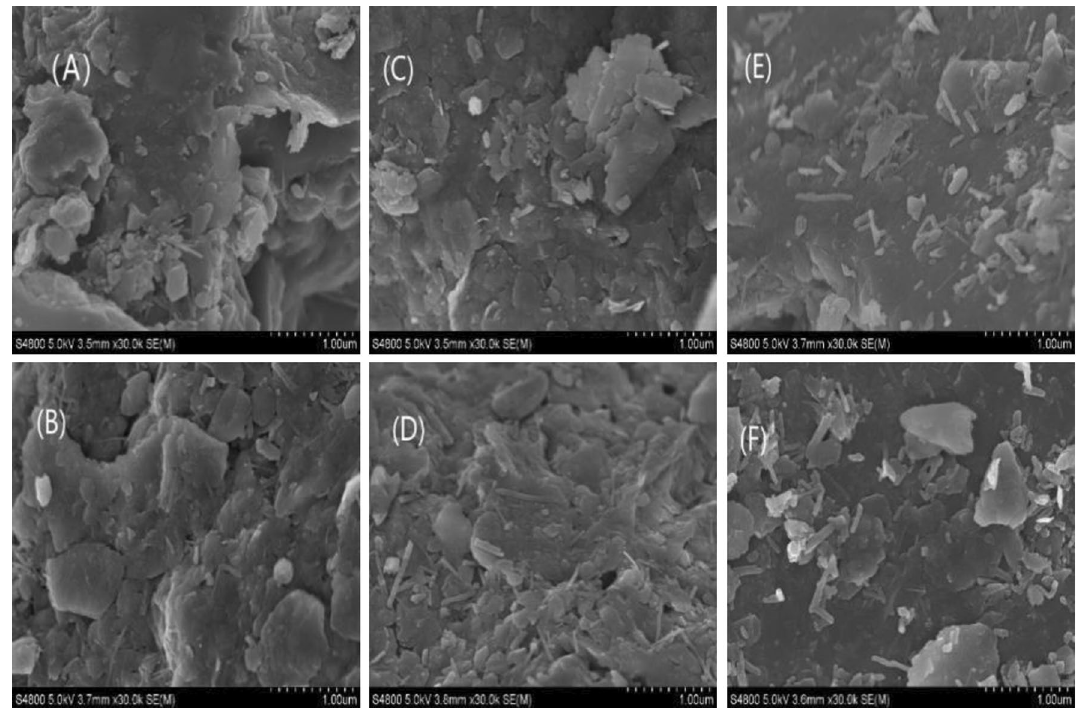
Figure 1. SEM micrographs of the three soil samples. ( A ) Silty sand; ( B ) Adsorbing 5 h of Silty sand; ( C ) Silts; ( D ) Adsorbing 5 h of Silts; ( E ) Loess; ( F ) Adsorbing 5 h of